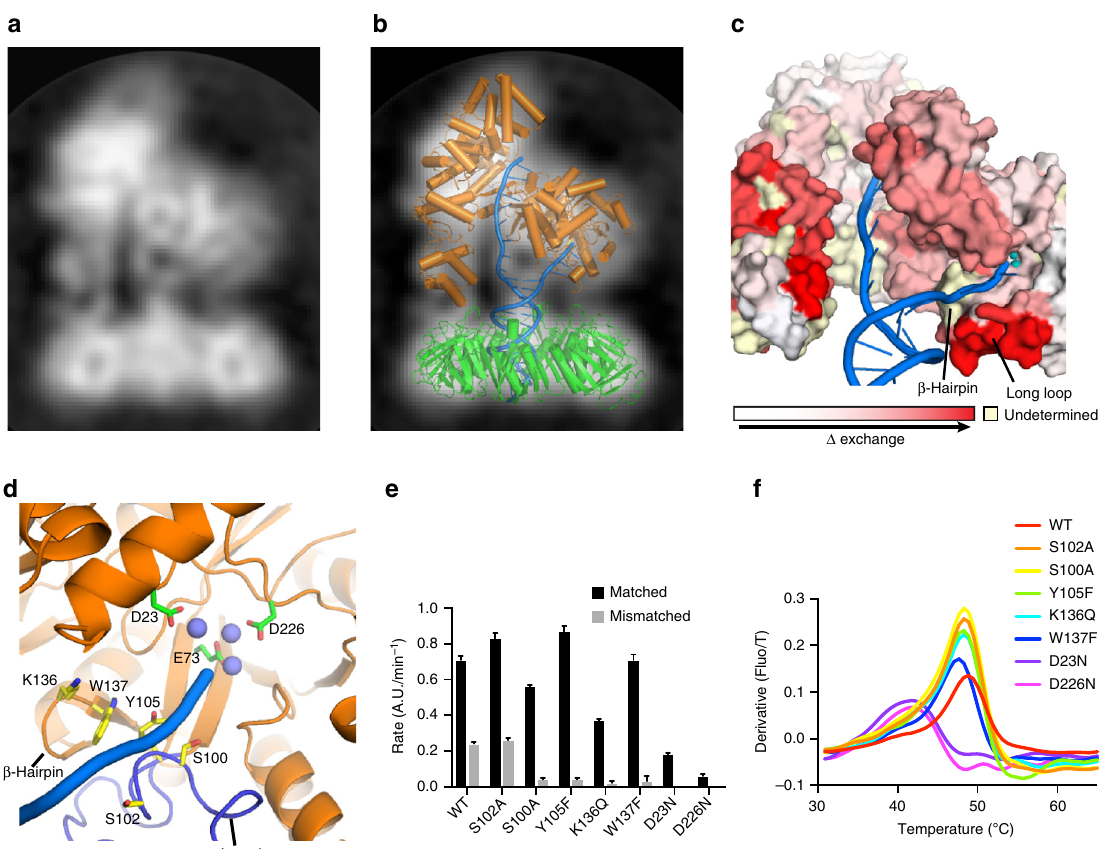
Fig. 3 Entry path of the primer strand into the PHP-exonuclease. a 2D cryo-EM class of the Mtb DnaE1 – clamp-DNA complex. b Fitting of the crystal structures of DnaE1 and β -clamp, and modeling of DNA into the 2D cryo-EM class. c Hydrogen – deuterium exchange experiments map the areas of the polymerase that are most affected by DNA binding, including the long loop in the PHP domain in contact with the modeled DNA. d Close up of the entry path and active site, with mutated residues indicated in sticks . The path of the modeled DNA is indicated by the blue line . e Primer extension rates of different DnaE1 mutants on a matched and mismatched DNA substrate calculated from three – fi ve independent experiments. Error bars indicate standard deviation (Supplementary Fig. 5). f Differential scanning fl uorimetry analysis of WT and mutant